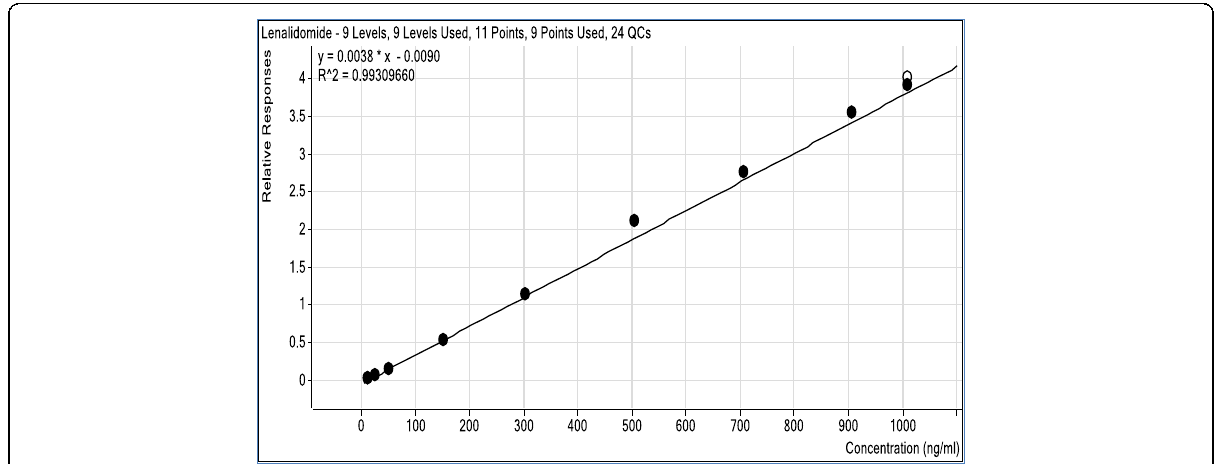
Fig. 4 Representative calibration curve for lenalidomide in